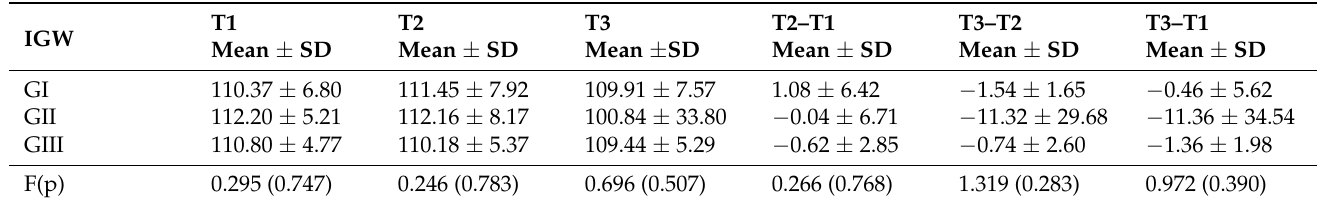
Table 4. Changes in intermandibular intergonial width (IGW) according to amount of mandibular